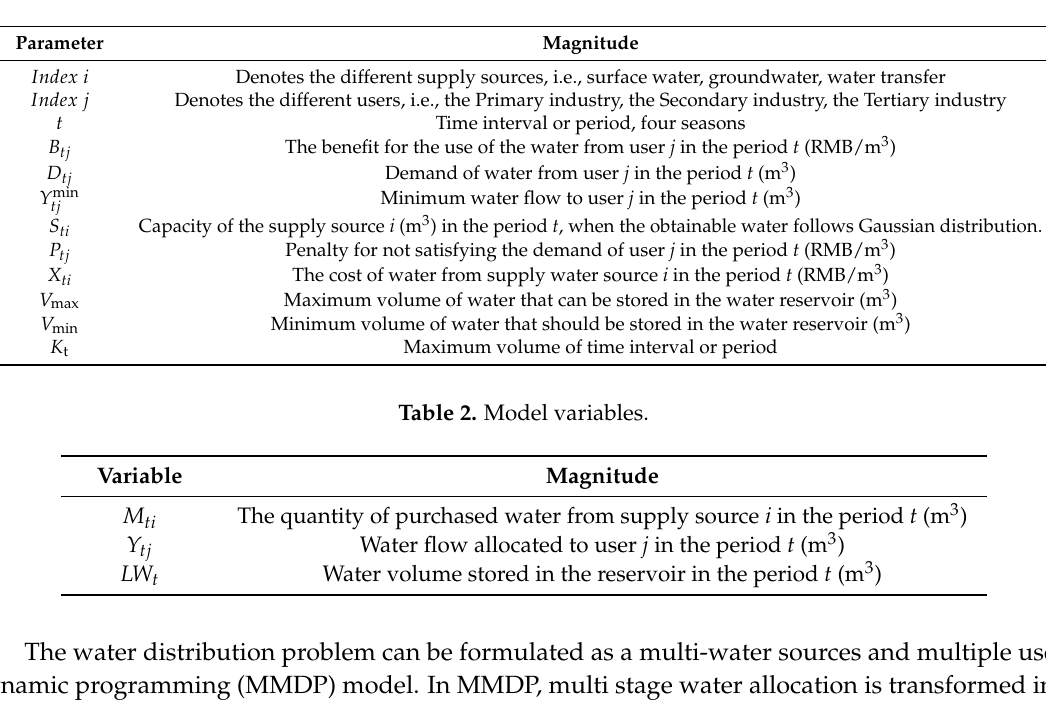
Table 1. Model parameters.